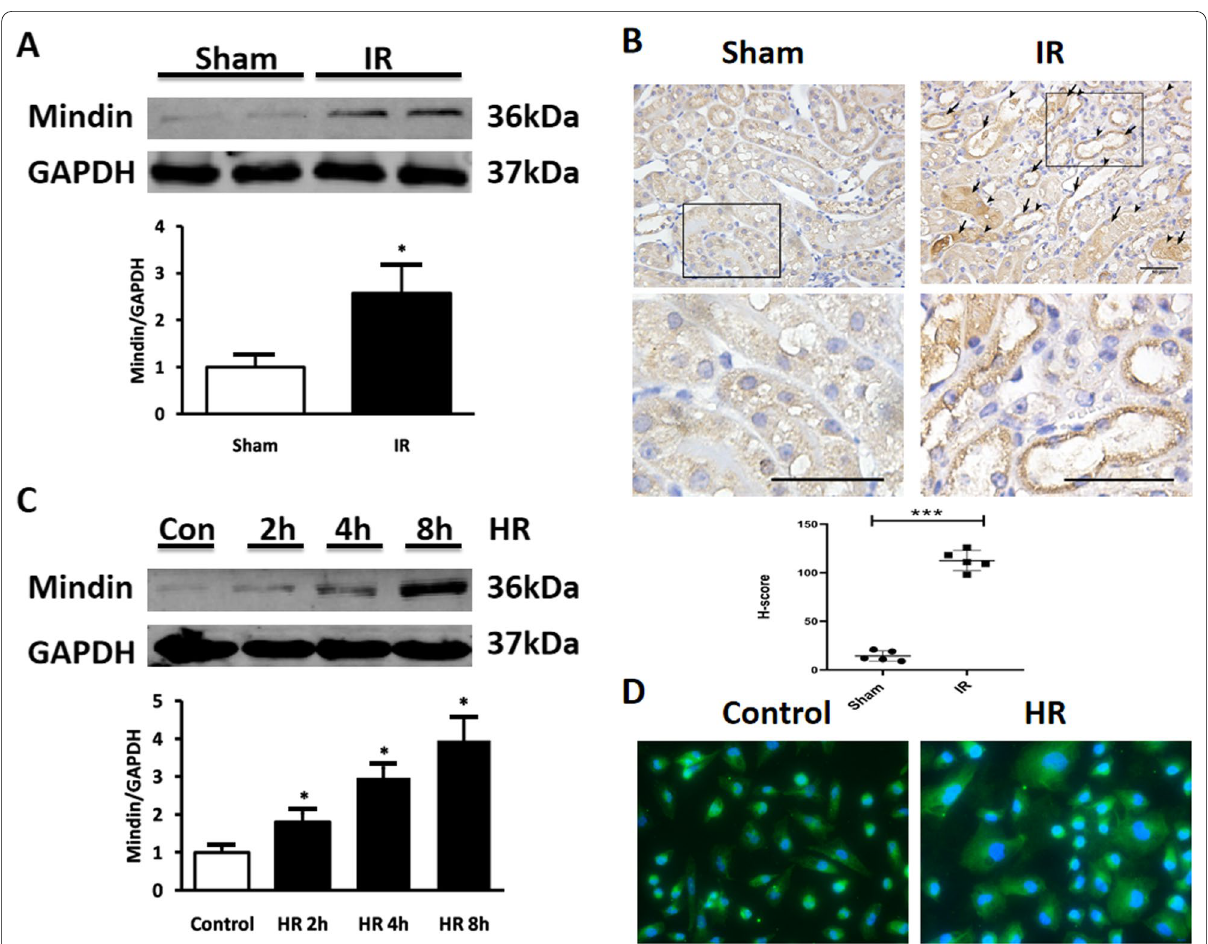
Fig. 1 Mindin expression was elevated in renal IR injury in vivo and in vitro. A Mindin measured by western blot analysis in sham mice and IR mice. Quantitative analysis of mindn protein expression. Expression levels were normalized to GAPDH and are presented relative to the sham-operated kidney. *P < 0.05 versus Sham. B Representative photomicrographs showing IHC analysis for mindin after 30 min renal ischemia and 24 h reperfusion (magnification 400 ). C Mindin measured by western blot analysis in HK-2 cells after 24 h hypoxia and 2, 4, and 8 h reoxygenation. × Quantitative analysis of mindin protein expression. Expression levels were normalized to GAPDH and are presented relative to the control cells. *P < 0.05 versus Control. D Representative photomicrographs showing immunofluorescence staining for mindin after 24 h hypoxia and 8